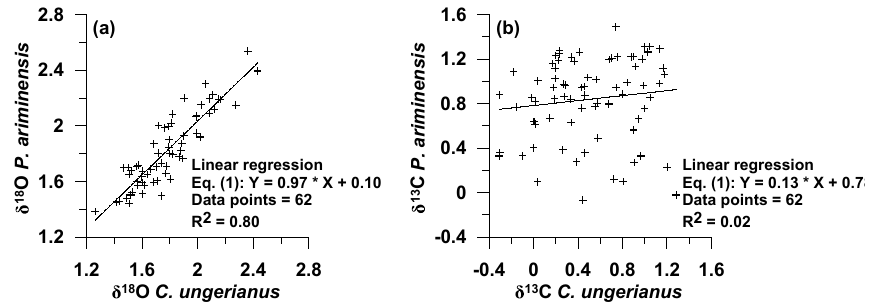
Figure 2. The δ 18 O (a) and δ 13 C (b) interspecies correlation between benthic foraminifera Cibicidoides ungerianus and Planulina arim- inensis at Site U1389. Parallel measurements were conducted throughout both investigated intervals. Linear square regression (black line) equation and Pearson correlation coefficient ( R 2 ) are shown.